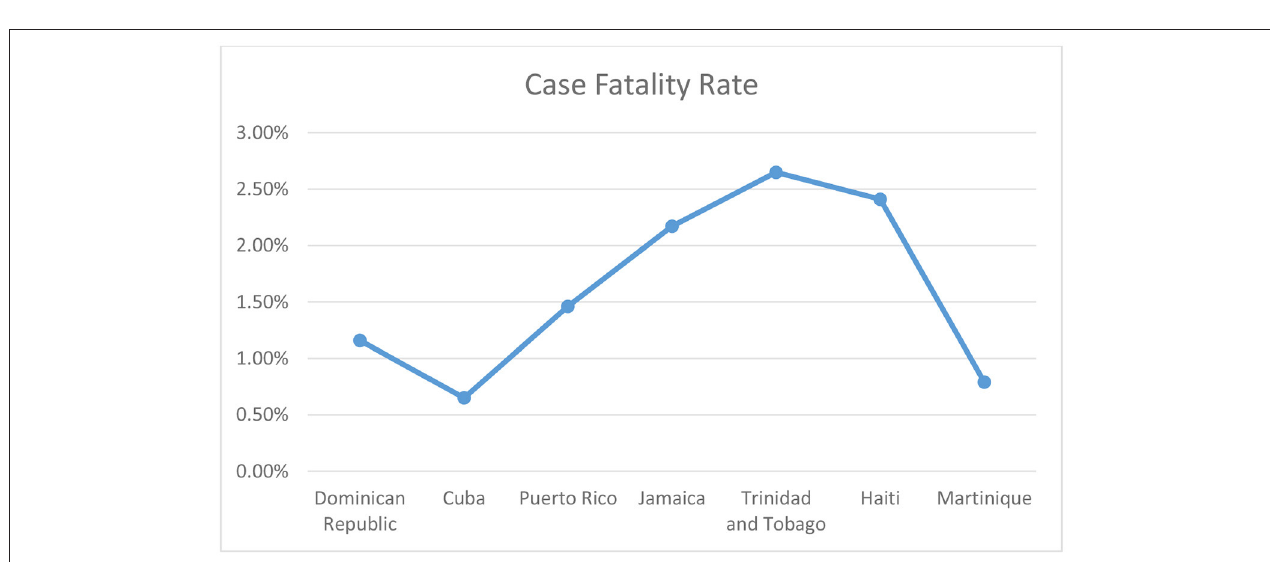
FIGURE 1 | The Caribbean region COVID-19 deaths as of December 2021.